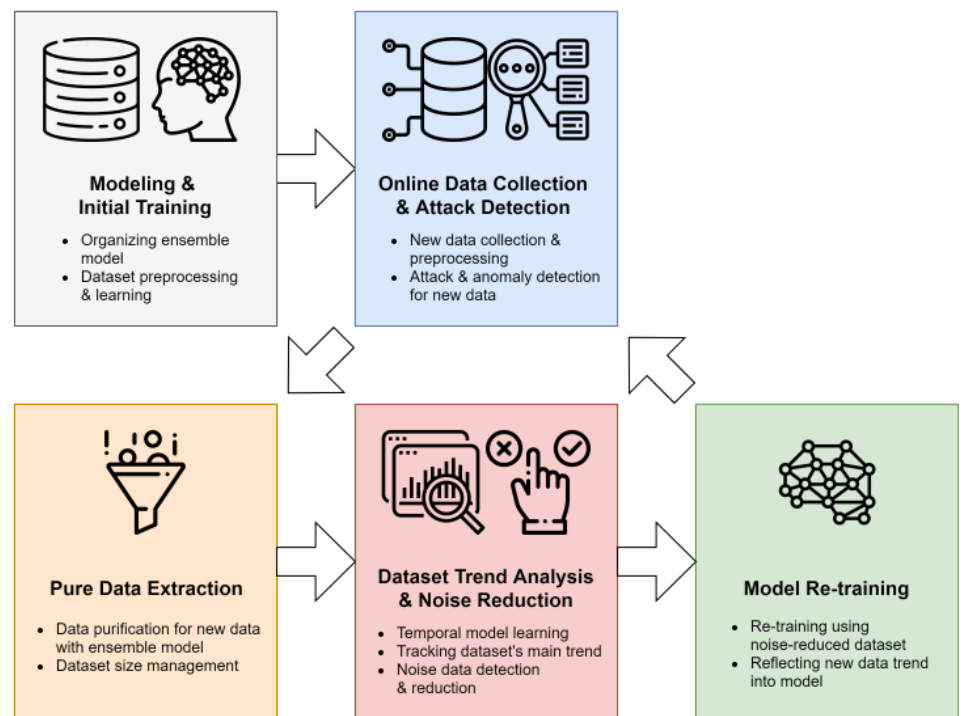
Figure 1. The overall process of the network attack detection framework through the proposed high-speed noise detection and data purification